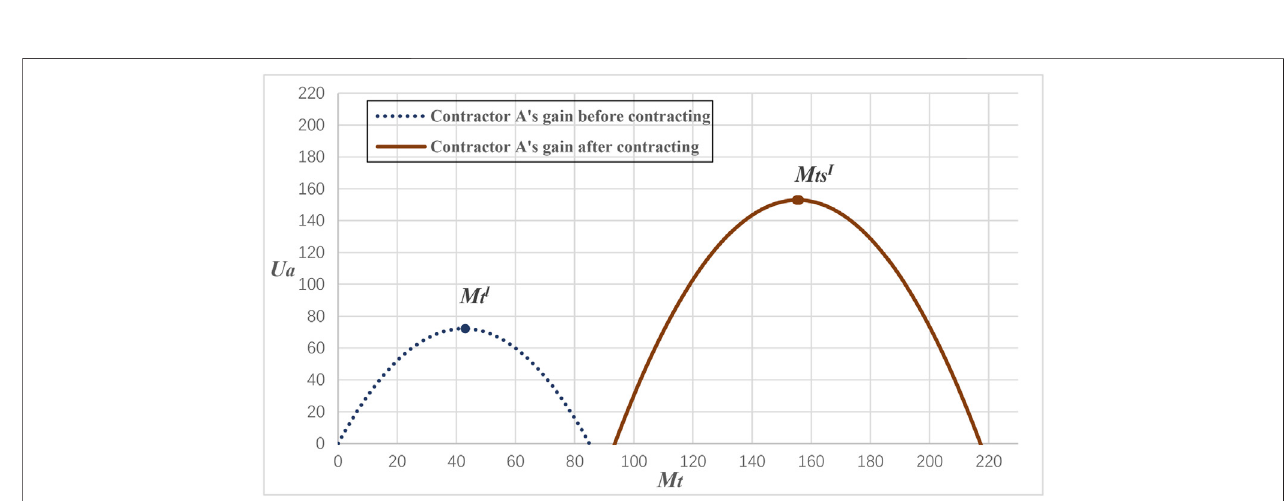
FIGURE 6 | The noncritical contractor ’ s gain function before and after contracting in Scenario II.